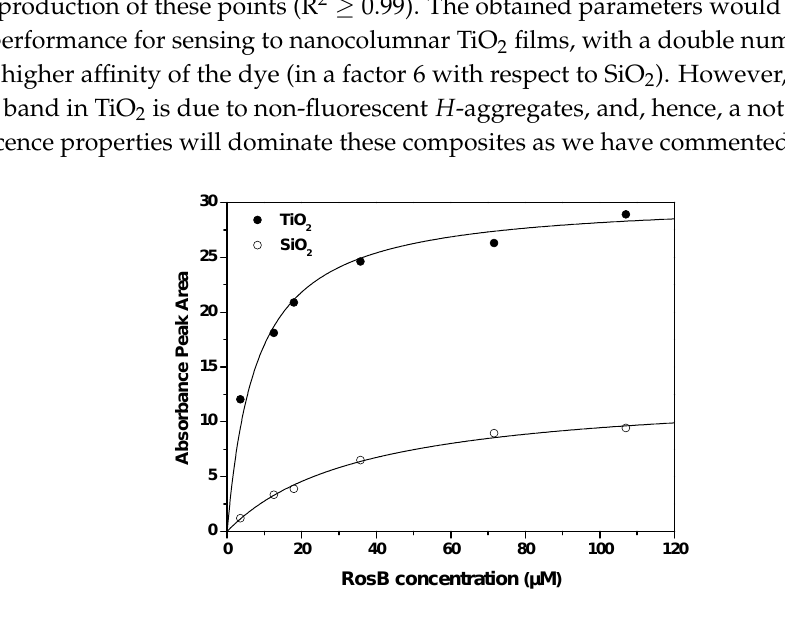
Figure 3. Adsorption behavior for RosB infiltrated in MO 2 films. The corresponding fit to a Langmuir-type function is denoted with a continuous line while experimental data are labeled with